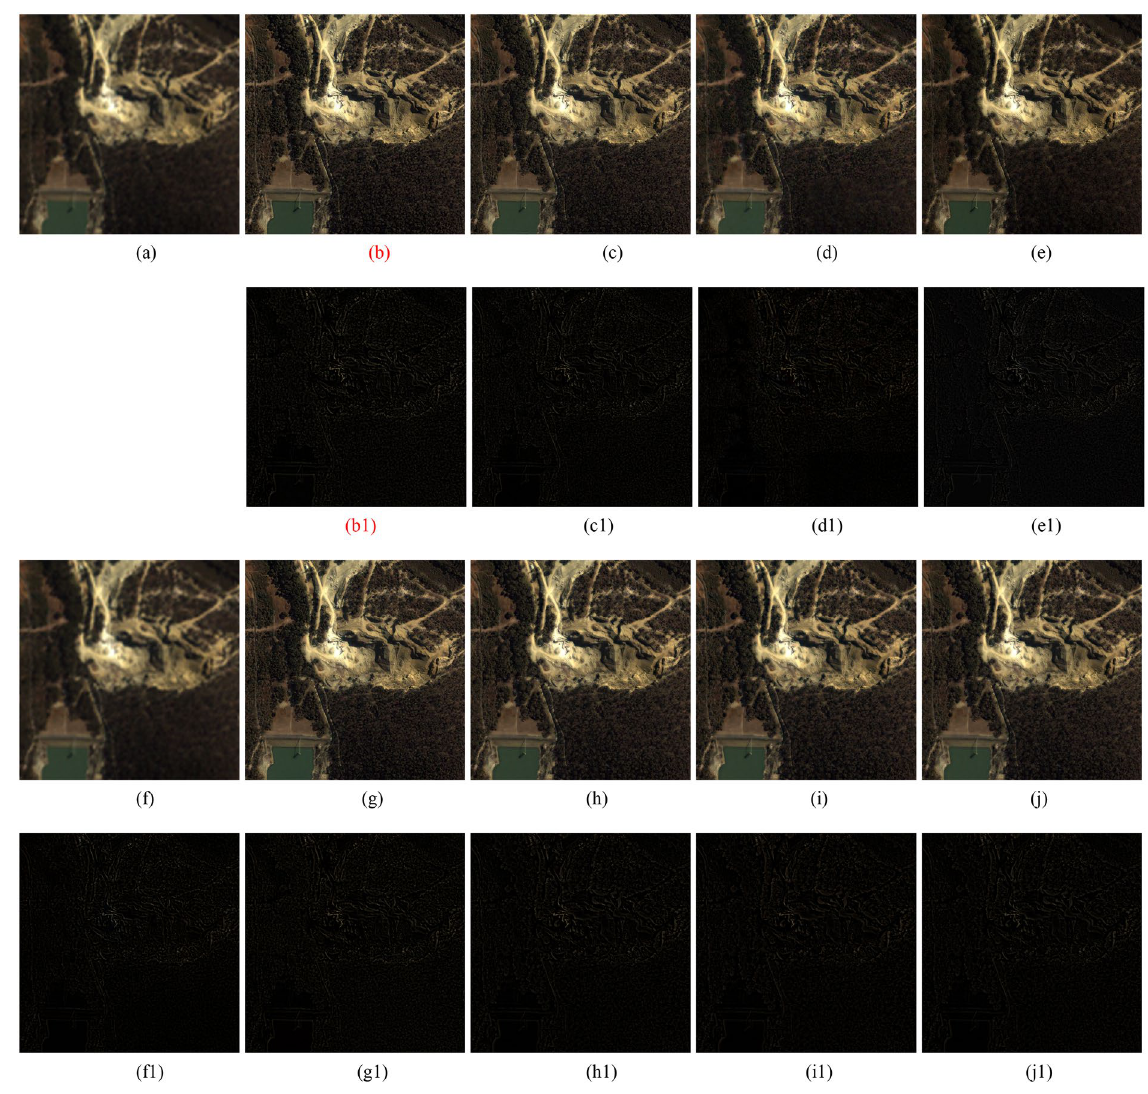
Figure 3. IKONOS images fusion results. ( a ) Ground truth. ( b ) GSA method. ( c ) CBD method. ( d ) BDSD method. ( e ) BF method. ( f ) MMMT method. ( g ) RBDSD method. ( h ) ASIM method. ( i ) DIM method. ( j ) Proposed method. ( b1 )-( j1 ) are the residual images.